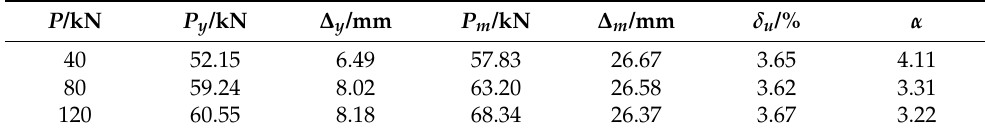
Figure 17. Hysteresis skeleton curve. Table 7. Characteristic points of skeleton curve of test piece.